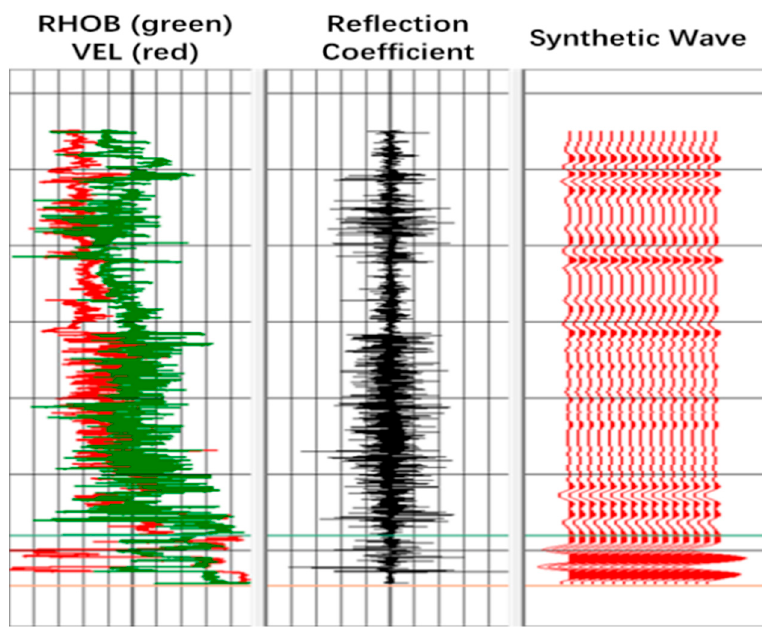
Figure 8. The synthetic seismic trace around well T615 as an